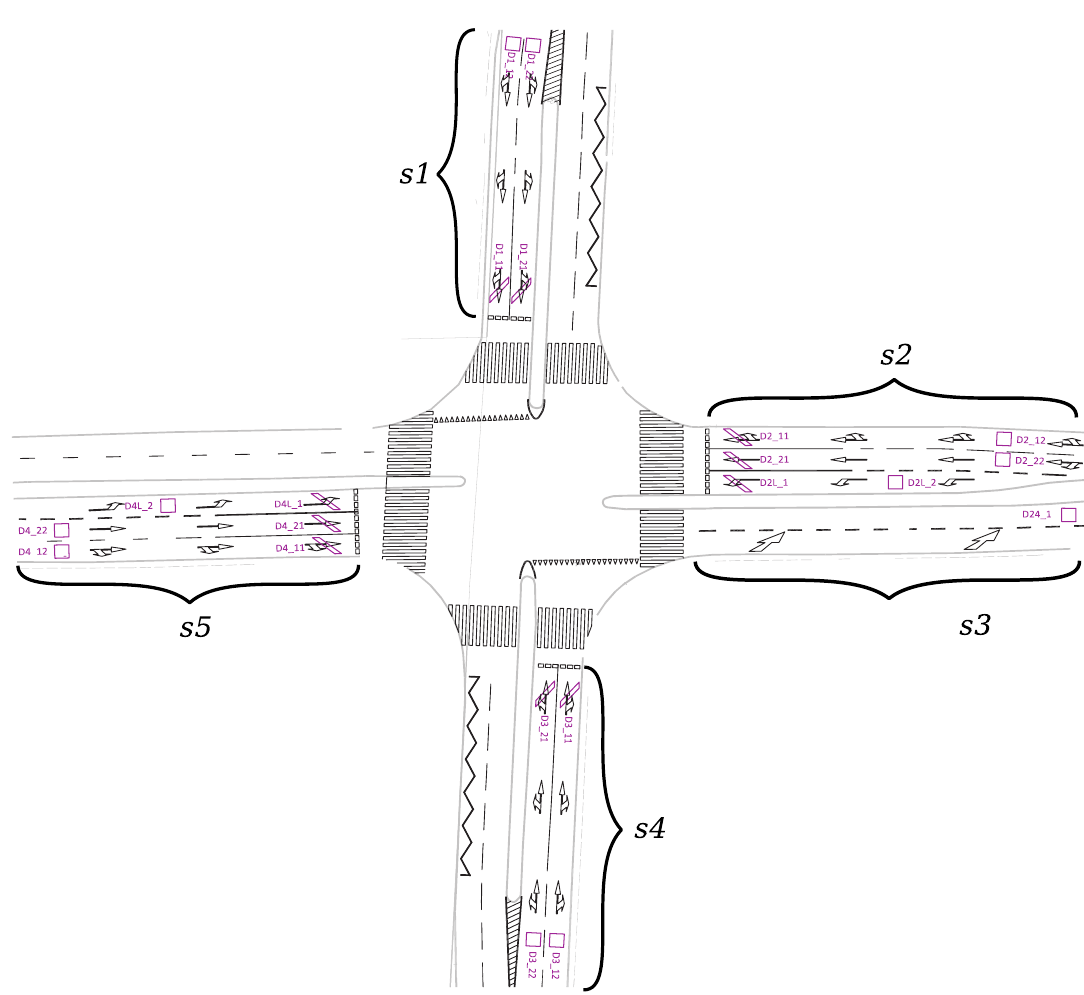
Figure 8. An example intersection, Krakow, Poland with inductive loops: D 2_11, D 2_12, D 2_21, D 2_22, D 4 L _2, D 4 L , D 4_22, D 4_21, D 4_12, D 4_11, D 3_11, D 3_12, D 3_21, D 3_22, D 1_12, D 1_11, D 1_22, D 1_21, D 24_1, and segments: s 1, s 2, s 3, s 4 and s